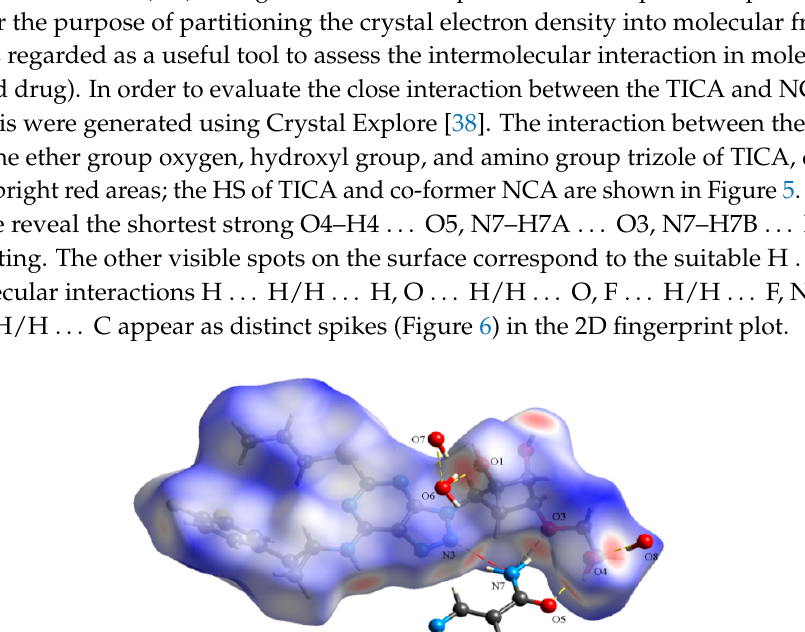
Figure 4. The FT-IR spectra of TICA, TICA-NCA, and TICA-NCA hydrate.